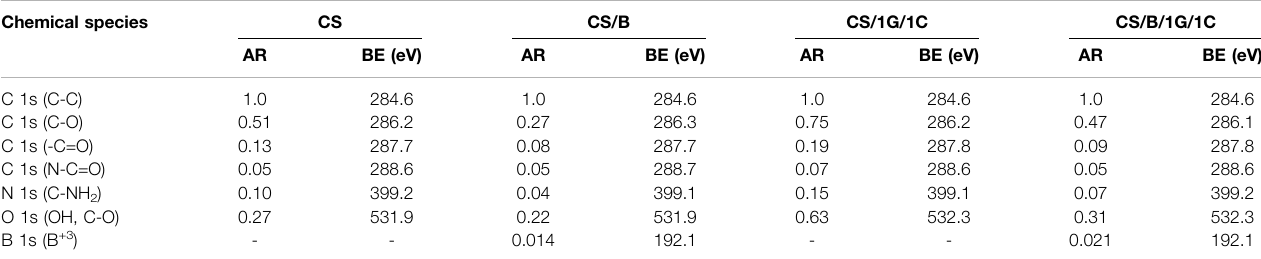
TABLE 2 | Values of the atomic ratio with component C-C (AR) and binding energy (BE) obtained from XPS analyses of pristine chitosan and chitosan composite fi lms. Chemical species CS CS/B CS/1G/1C CS/B/1G/1C AR BE (eV) AR BE (eV) AR BE (eV) AR BE (eV) C 1s